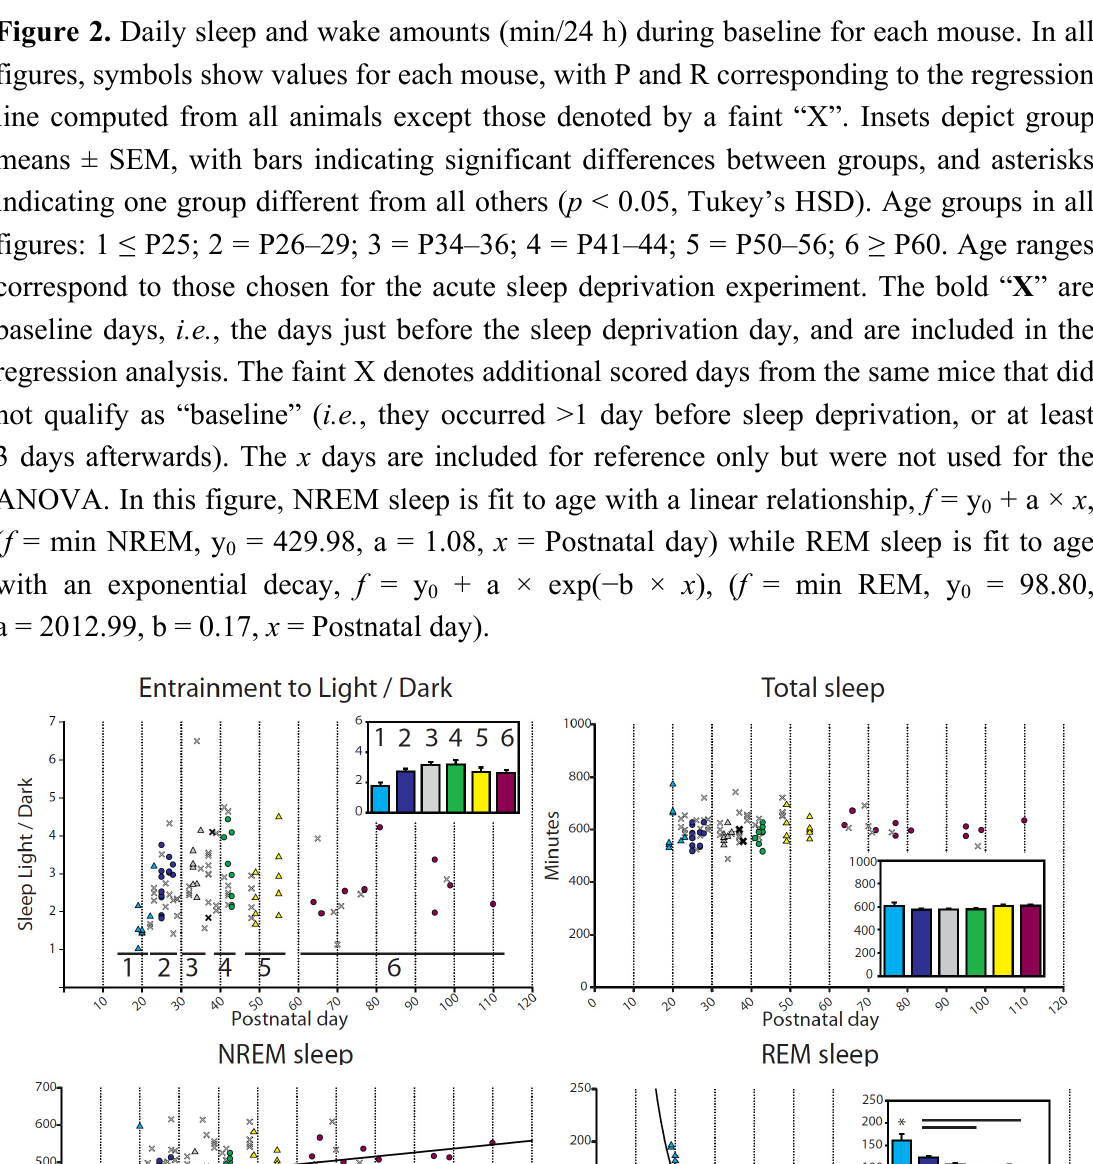
Figure 2. Daily sleep and wake amounts (min/24 h) during baseline for each mouse. In all figures, symbols show values for each mouse, with P and R corresponding to the regression line computed from all animals except those denoted by a faint “X”. Insets depict group means ± SEM, with bars indicating significant differences between groups, and asterisks indicating one group different from all others ( p < 0.05, Tukey’s HSD). Age groups in